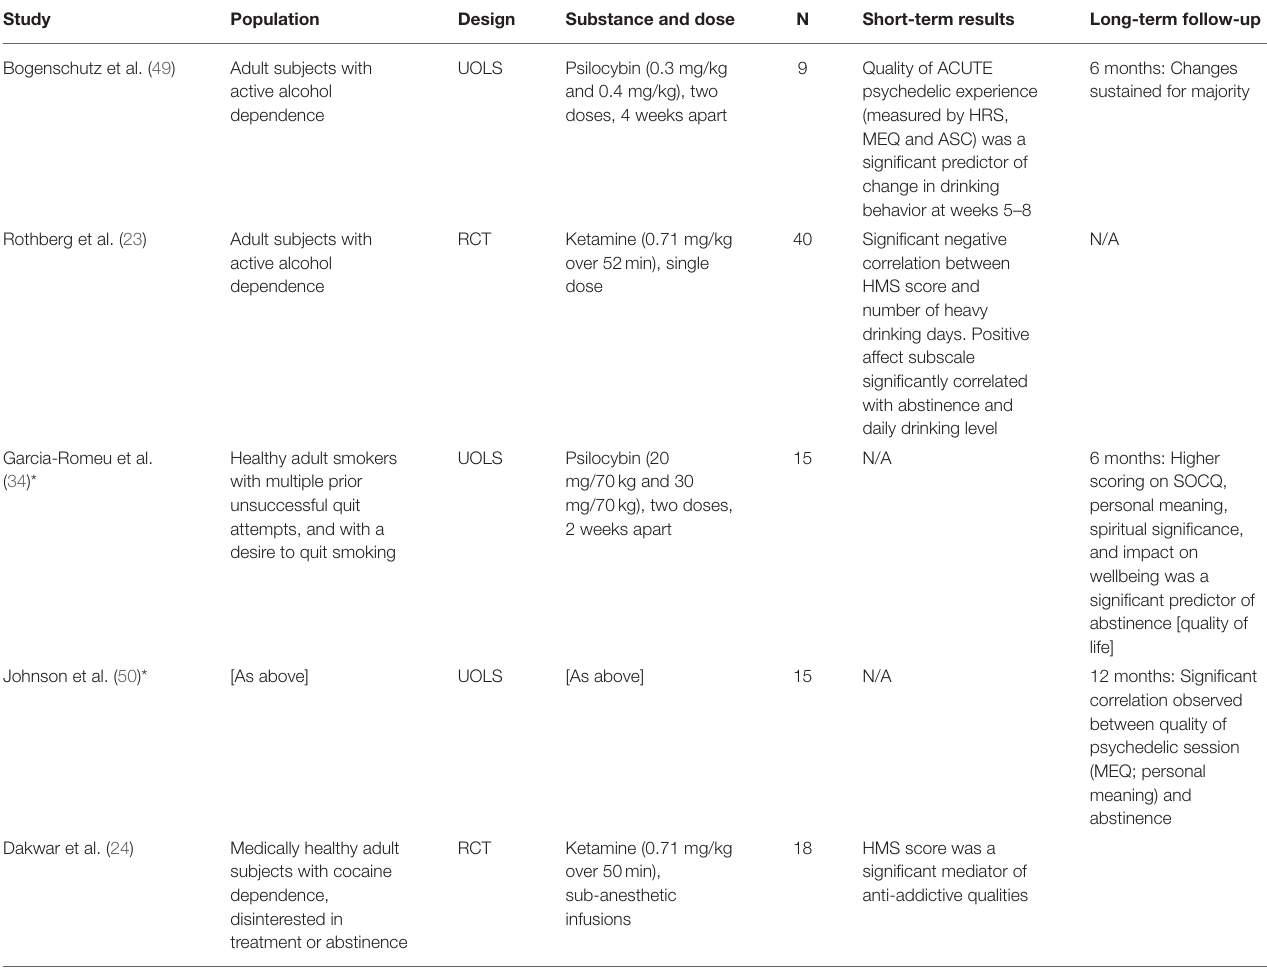
TABLE 5 | Substance use disorder